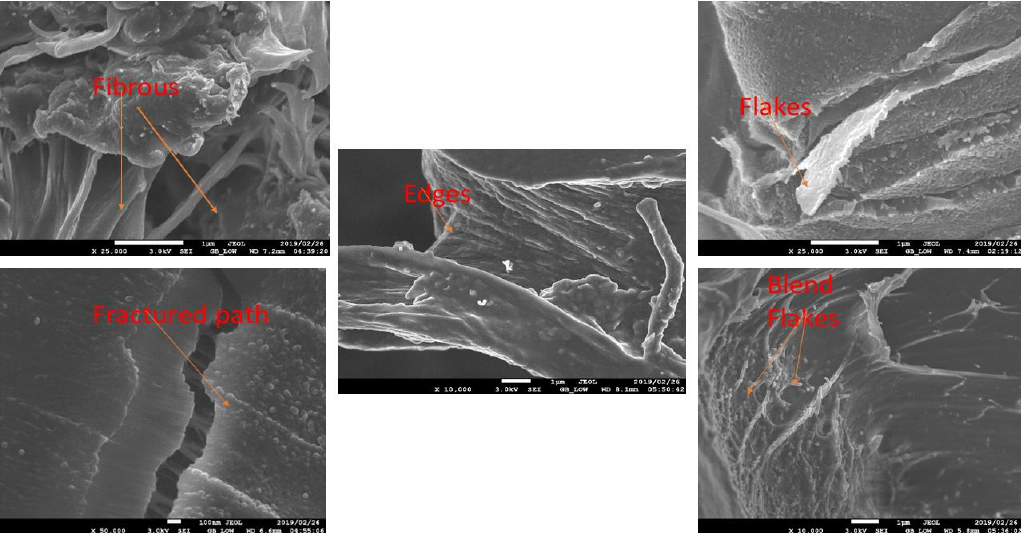
Figure 10. SEM fracture images of high magnification PLA–chitin–starch.